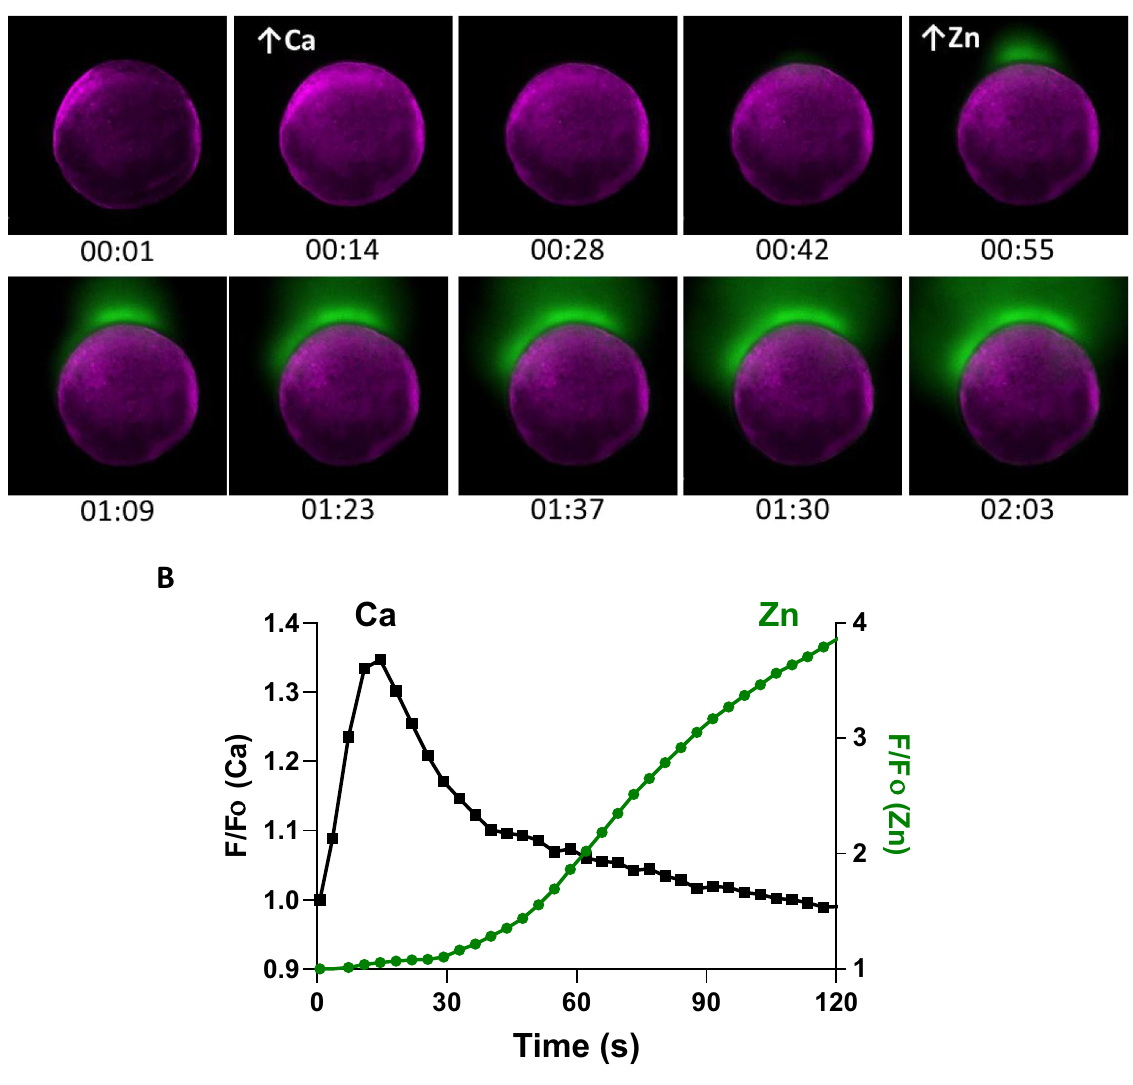
Figure 6. A rise in intracellular calcium proceeds zinc exocytosis in WT eggs. (A) Representative time- course images from concurrent intracellular calcium (purple) and extracellular zinc (green) monitoring. (B) Representative time trace of normalized calcium (black) and zinc (green) fluorescence